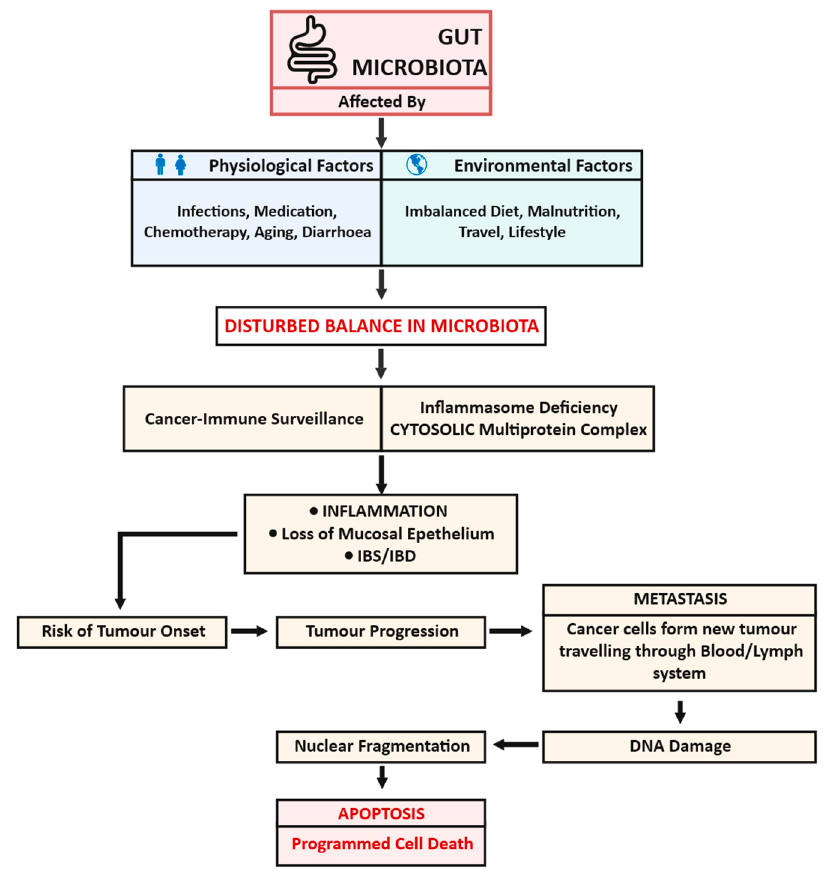
Figure 1. Variations in gut microbiota and their effect on the development and progression of health issues.